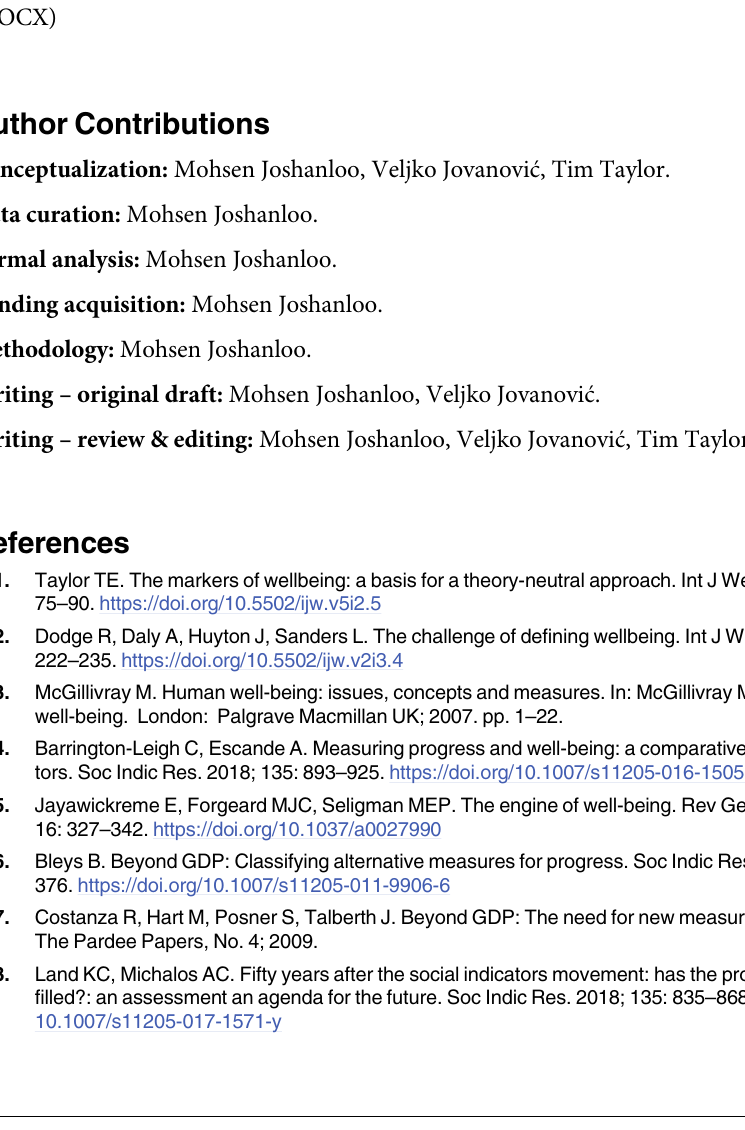
S1 Fig. The relationship between psycho-social functioning and socio-economic progress. S2 Fig. The relationship between negative affectivity and socio-economic progress. S3 Fig. The relationship between negative affectivity and psycho-social functioning. S1 Table. Descriptive information for the main dataset (2015–2017). S2 Table. Gallup items used in the study. S3 Table. Intercorrelations between the 24 indicators. S4 Table. Global regions (Gallup’s